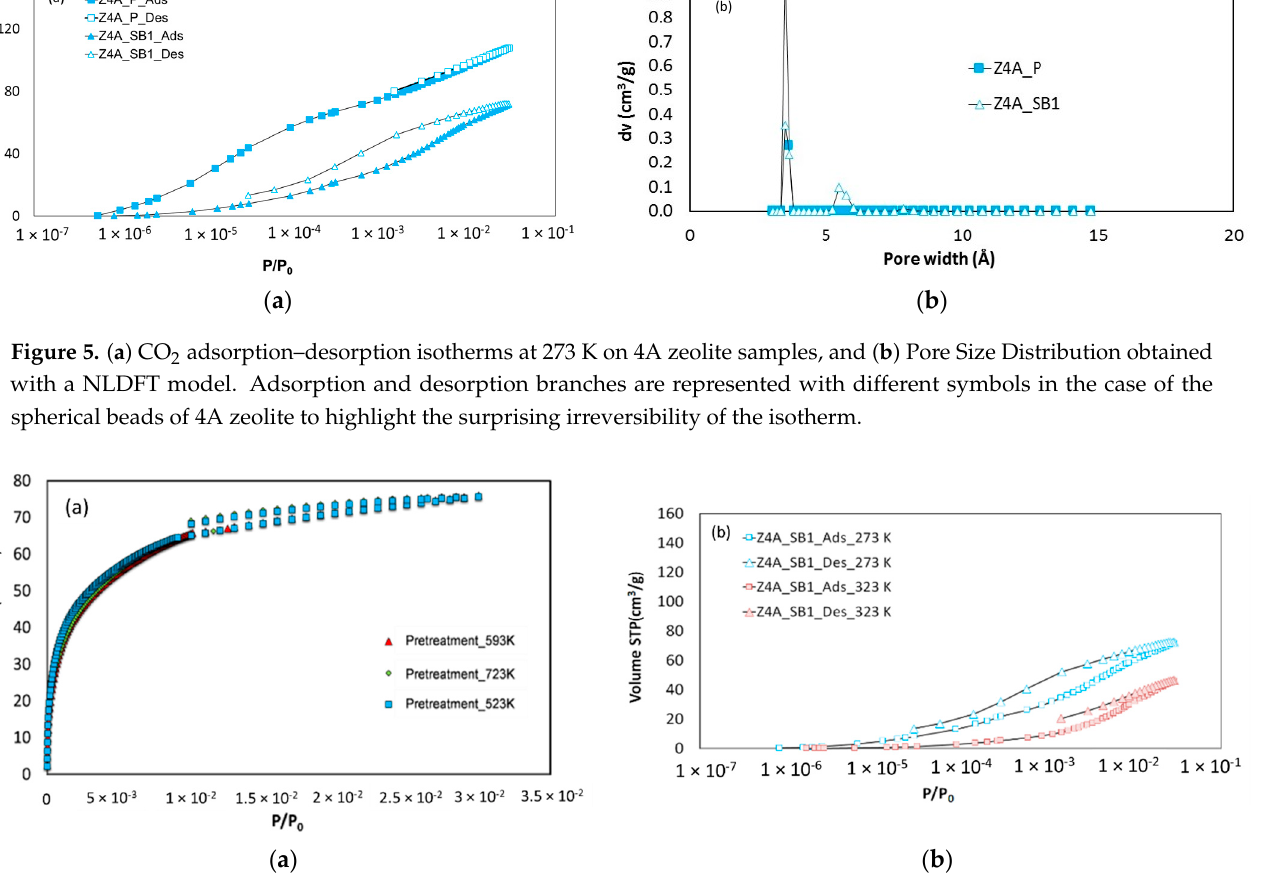
Figure 5. ( a ) CO 2 adsorption–desorption isotherms at 273 K on 4A zeolite samples, and ( b ) Pore Size Distribution obtained with a NLDFT model. Adsorption and desorption branches are represented with different symbols in the case of the spherical beads of 4A zeolite to highlight the surprising irreversibility of the isotherm.